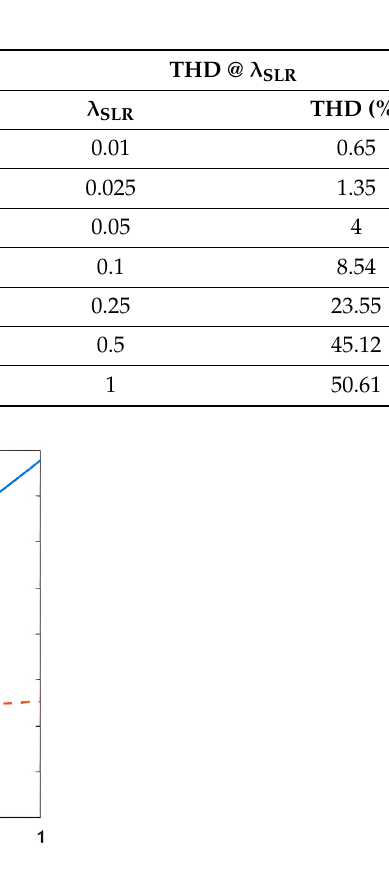
Figure 7. Switching losses—Mode IV with Balanced Reference Currents